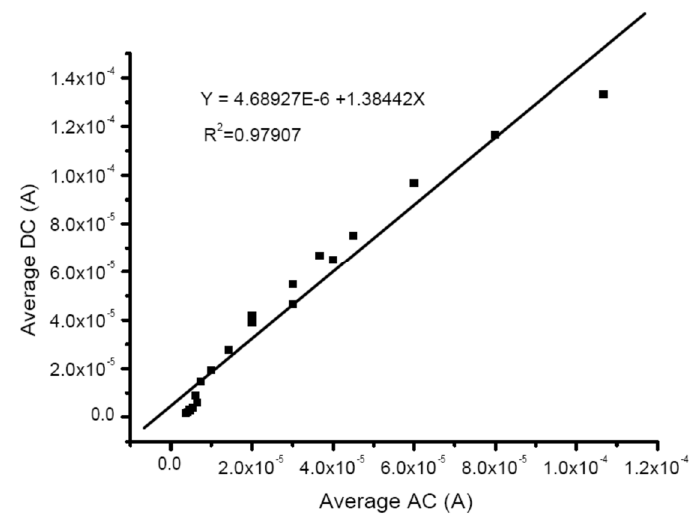
Figure 7. Linear fitting of average DC versus average AC during the time-course experiment in 3 × 10 6 s (34.7 days).